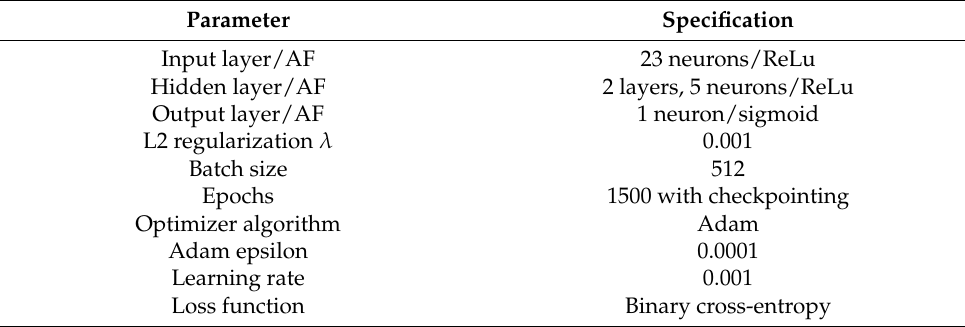
Table 7. Neural network model final hyperparameters. AF: activation